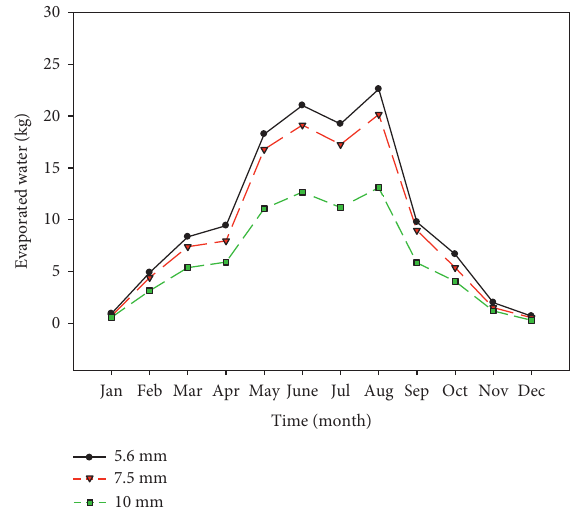
Figure 17: Effect of water depth on monthly evaporated water for reactor inclined at 1 ° , Re � 9000, and aspect ratio � 180.